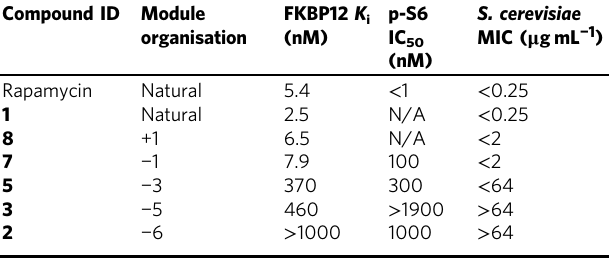
Table 1 Biological activity of rapalogs Compound ID Module